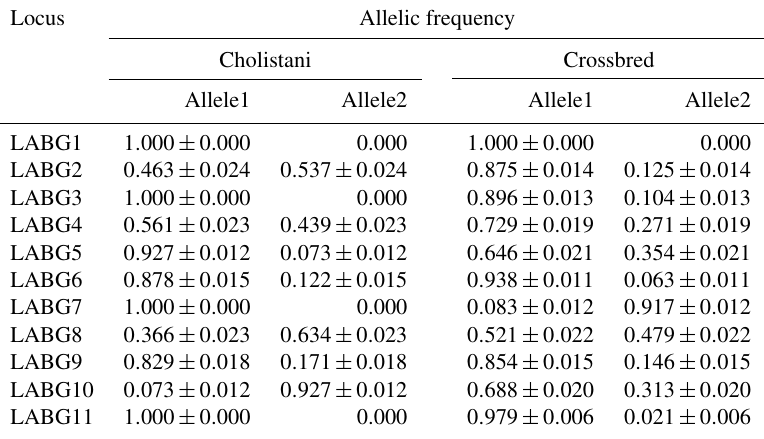
Table 5. Allelic frequencies of Cholistani and crossbred cattle for 11 markers. Locus Allelic frequency Cholistani Crossbred Allele1 Allele2 Allele1 Allele2 LABG1